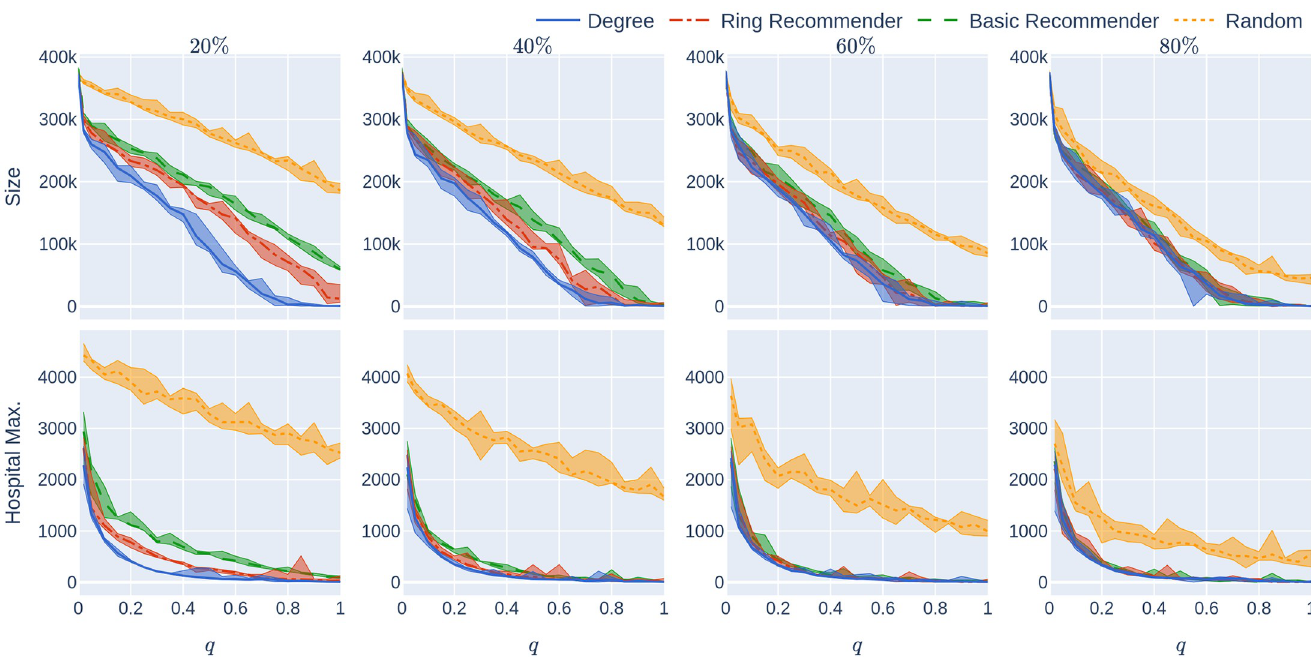
Fig 11. Experiment 2 on a geometric network with many super-spreaders: Influence of the quarantine strictness q for various uptake percentages p % and the four uptake scenarios at infection rate β = 0.05. The underlying network is a 500,000-node GIRG with τ = 2.3 (more super-spreaders) and α = 2.3 (more geometric). Each column represents an uptake percentage. The x -axis shows the quarantine strictness q varying from 0 to 1 at step size 0.05. Simulations are done for the 21 values of q corresponding to these steps. There is an additional simulation point at 0.02 (in order to avoid division by 0 in the computation for HMax and still have a point close to 0). The y -axis shows the corresponding value of the KPI. The curves in each figure correspond to the different uptake scenarios, as labelled. For each parameter value, the plotted result is the median over 5 runs. The shaded region around the plot covers the results of all 5 simulations. The epidemic is started by infecting 100 individuals, chosen uniformly at random. Simulation is halted when there are no more exposed or infected